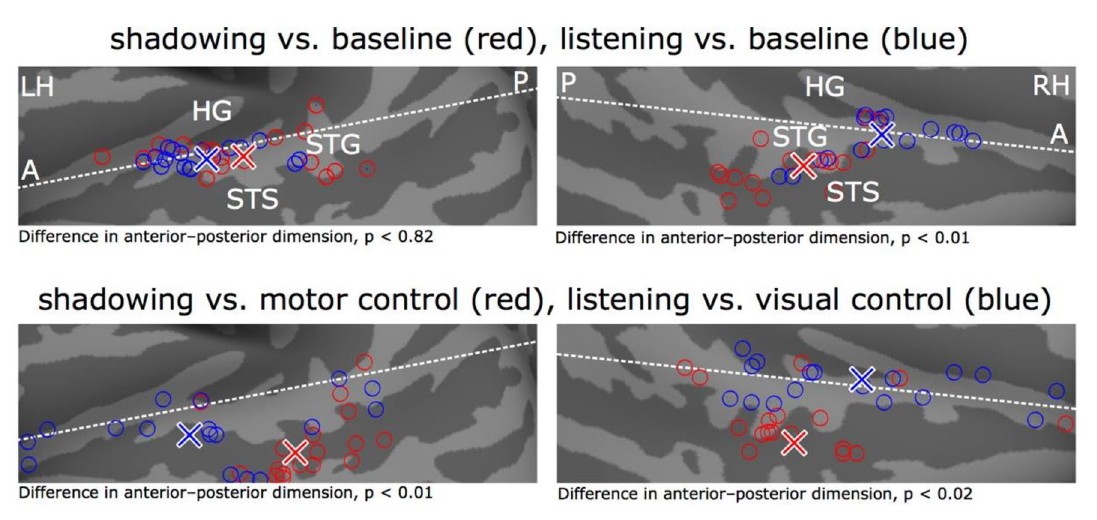
Figure 4. The peak coordinates for the AV speech listening task are significantly anterior to the peak coordinates for the shadowing task in the STG/STS. The white lines denote the anterior–posterior dimension in the STG, individual peak coordinates for the listening task (vs. baseline) are denoted by blue circles (mean blue cross) and the corresponding peak coordinates for the shadowing task are denoted by red circles (mean red cross). The upper row shows the peak coordinates for the task vs. baseline in the left and right STG/STS (lighter gray denotes gyri and darker gray sulci) The lower row shows the peak coordinates for the listening and shadowing tasks contrasted with their respective control task, that is, visual control and motor control task, respectively, controlling for stimulus and speech production related effects. LH left hemisphere, RH right hemisphere, A anterior, p posterior, HG Heschl’s gyrus, STG superior temporal gyrus, STS superior temporal